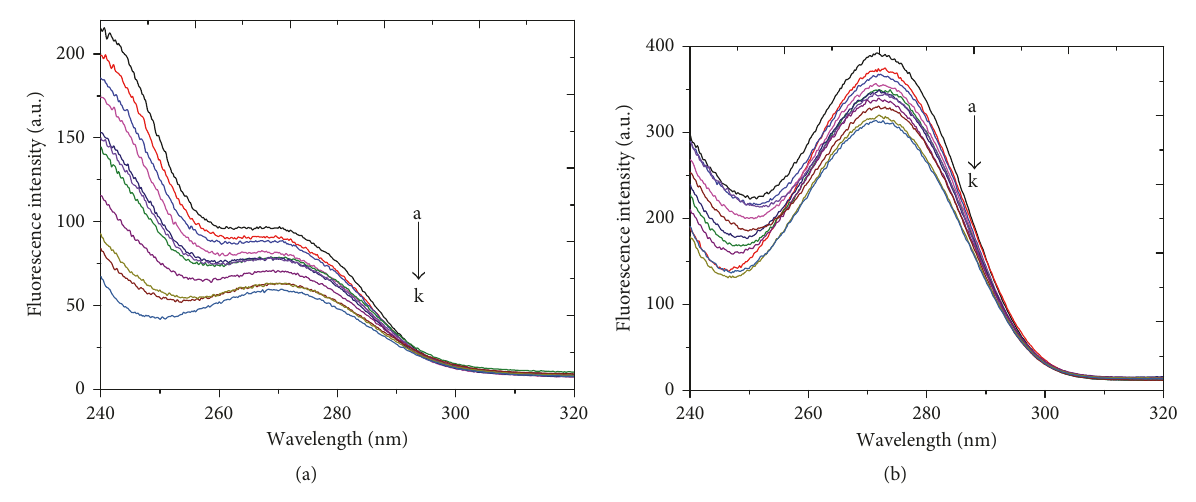
Figure 5: Synchronous fluorescence spectra of BSA (2 . 5 × 10 − 6 mol · L − 1 ) after interaction with RSN (0 to 5 . 5 × 10 − 6 mol · L − 1 ) at 297 K and pH 7.40: (a) Δ λ � 15nm for Tyr and (b) Δ λ � 60nm for Trp.